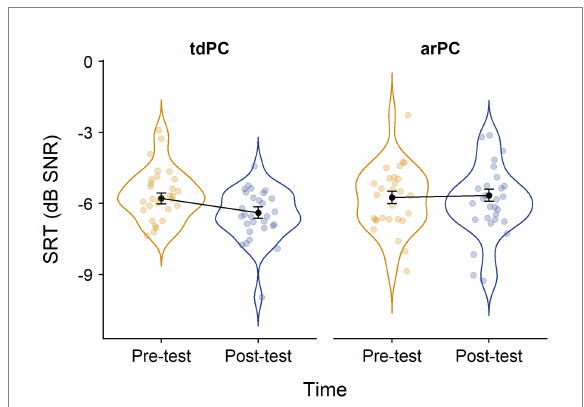
FIGURE 2 Distribution of the raw SRT values across groups and timepoints. SRT, speech reception threshold; tdPC, typically developing passive control group; and arPC, at-risk passive control group. Black dots and error bars represent the model estimates and their standard errors, respectively. Lower SRTs mean better speech-in- noise perception